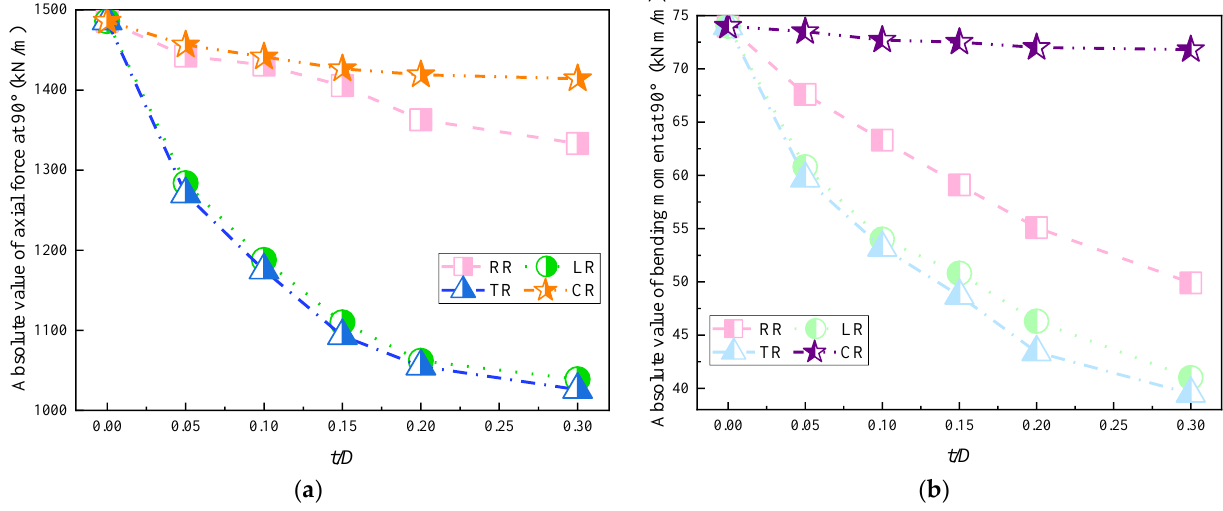
Figure 12. Variation of the maximum axial force and the bending moment at 90° of the preceding tunnel lining with t : ( a ) axial force; ( b ) bending moment.